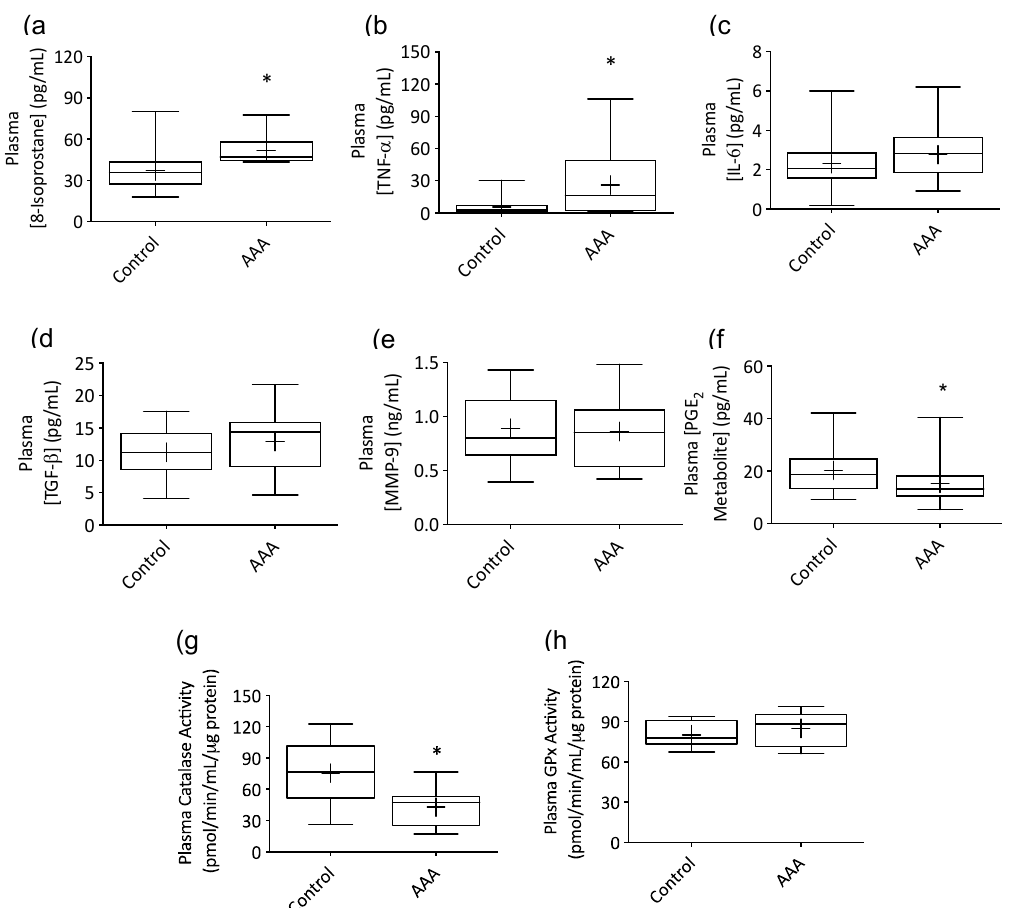
Figure 1. Plasma 8-isoprostane and cytokine concentrations and antioxidant enzyme activity in patients with small AAA and healthy control participants. Plasma 8-Isoprostane ( a ; AAA n = 10, control n = 17) and tumor necrosis factor alpha (TNF-α; b ; AAA n = 19, control n = 34) concentrations were markedly elevated and catalase activity ( g ; AAA n = 9, control n = 16) and PGE 2 metabolite levels ( f ; AAA n = 30, control n = 34) significantly reduced in AAA patients compared to control participants. Interleukin-6 (IL-6; c ), transforming growth factor-β (TGF-β; d ), matrix metalloproteinase-9 (MMP-9; e ) concentrations and glutathione peroxidase activity (GPx; h ) were similar across groups. Box plots show 25th, 50th (median) and 75th percentiles (horizontal lines), mean (+) and minimum and maximum values (whiskers). * p < 0.05 (Mann-Whitney analysis).